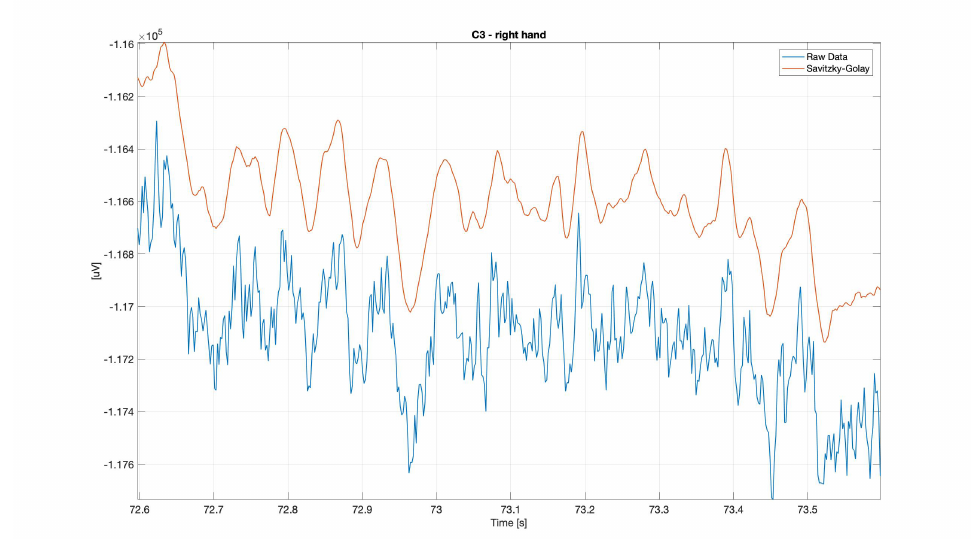
Figure 18. Raw and Savitzky–Golay filtered electroencephalography (EEG) data—clearly visible ‘alpha’, imagery